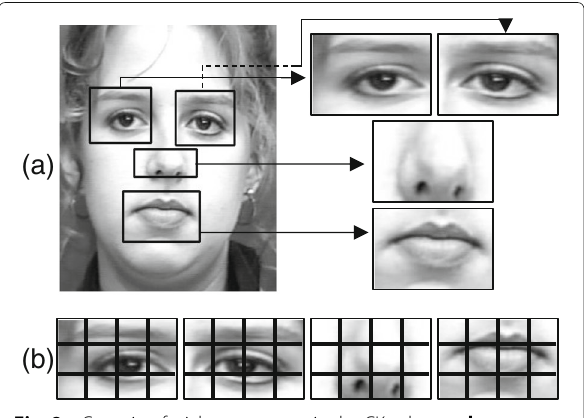
Fig. 8 a Cropping facial components in the CK+ dataset. b Segmenting each component into a 3 × 4 region